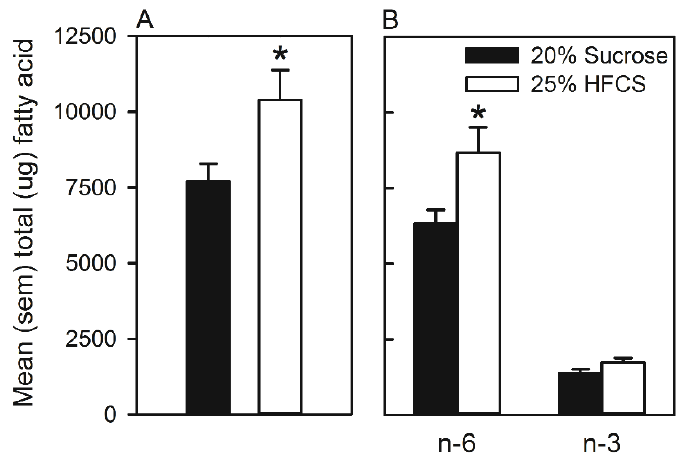
Figure 8. ( A ) Mean (SEM) total fatty acids (µg) measured in the livers of rats that self-administered 25% HFCS or 20% sucrose in home cages. ( B ) Mean